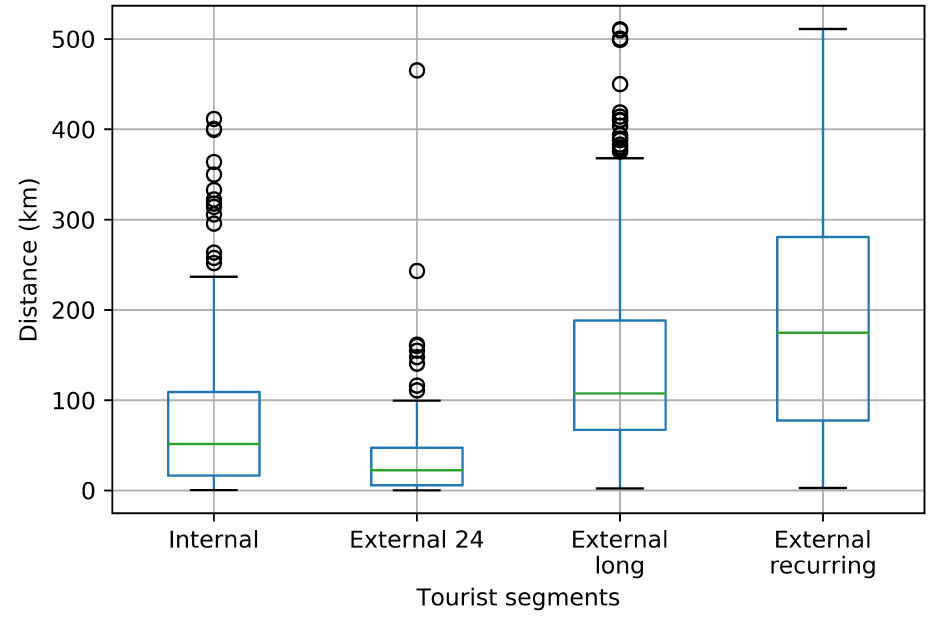
Figure 11. Total distance